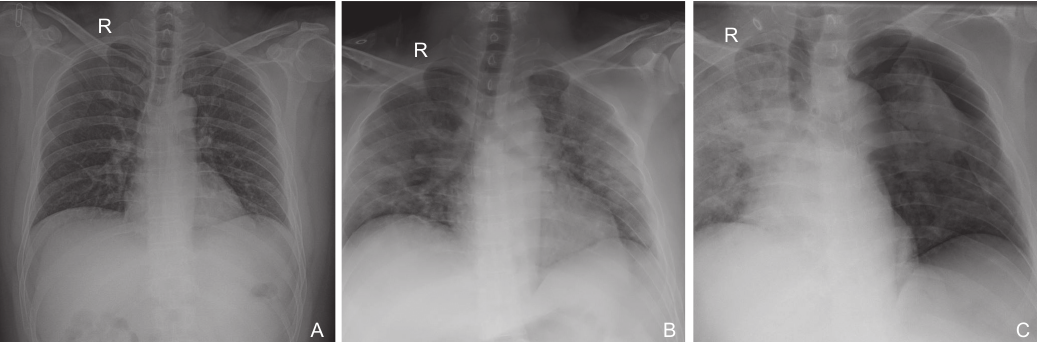
Figure 1 Chest X-ray findings. (A) On January 16, the texture of both lungs was enhanced and blurred, and it was recommended to re-examine after treatment; (B) On January 27, the texture of both lungs became thicker, increased, blurred, and the patch-like blur was seen in the outer band of the lesion; bilateral hilar flocculation, suggesting infectious lesions in both lungs, and possible viral pneumonia; (C) On February 8, the texture of both lungs became thicker and thicker, scattered in patchy and flocculent blurs, with blurred edges, and the left lung field tissue was compressed by about 30%; considering the left pneumothorax, bilateral lung infection, and the lesions